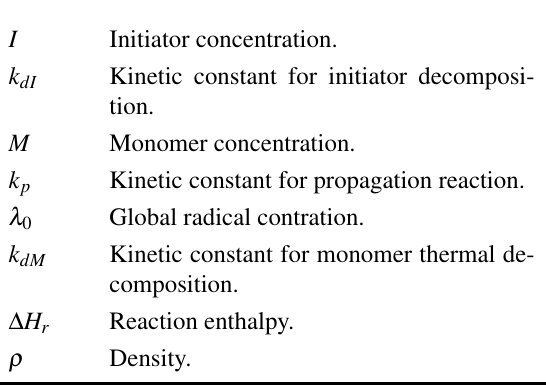
Table 1: Nomenclature of the model